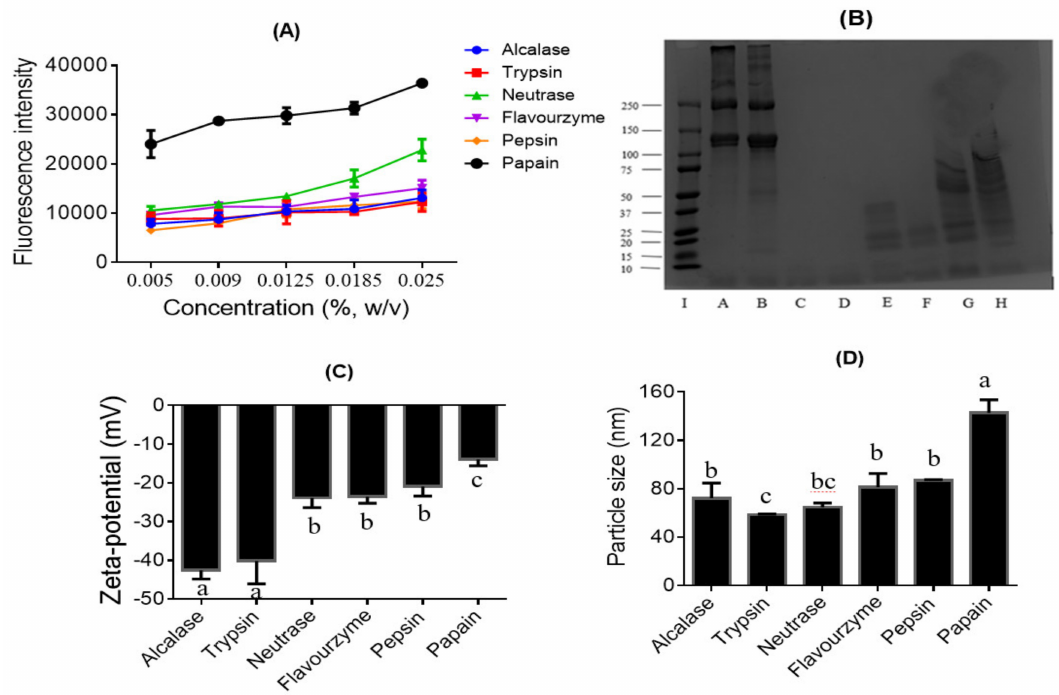
Figure 1. Properties of the collagen protein hydrolysates. ( A ) Surface hydrophobicity (H 0 ), ( B ) SDS-PAGE protein profile, ( C ) zeta potential, and ( D ) mean particle size of the collagen hydrolysates produced by Alcalase, trypsin, Neutrase, Flavourzyme, pepsin and papain. Mean values with different letters in ( C ) and ( D ) are significantly different with p < 0.05. SDS-PAGE label: Lanes I: High molecular-weight protein marker, A = Acid-solubilized collagen (ASC), B = Pepsin-solubilized collagen (PSC), and collagen hydrolysates obtained using C = trypsin, D = Alcalase, E = Flavourzyme, F = Neutrase, G = pepsin, and H =